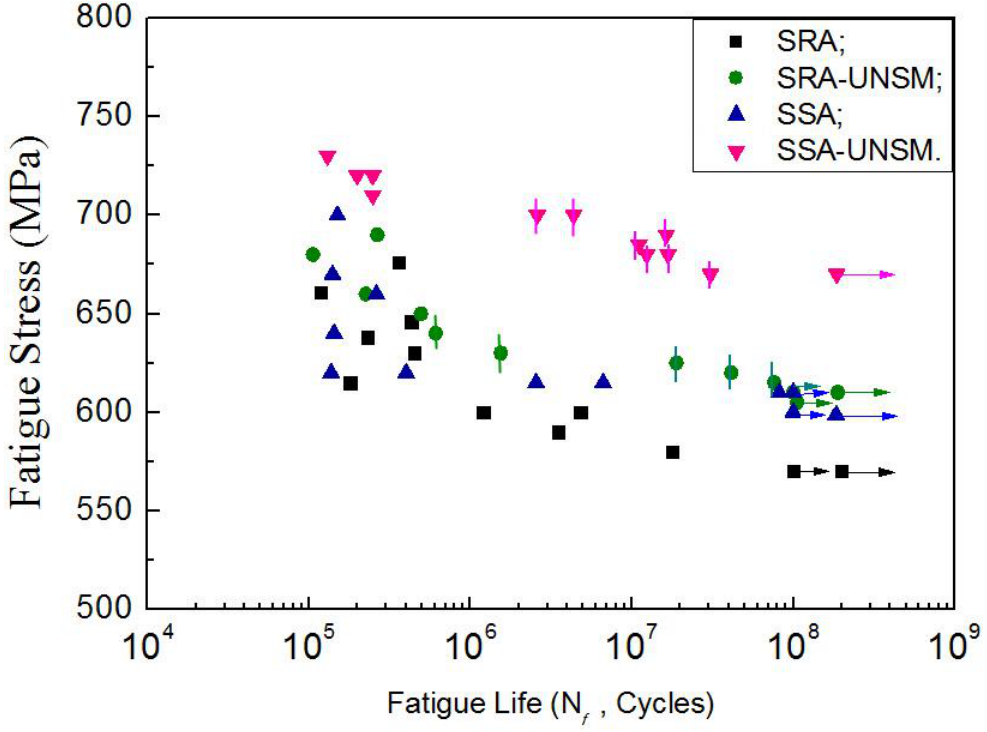
Figure 6. S–N curves of TC4 before and after UNSM.